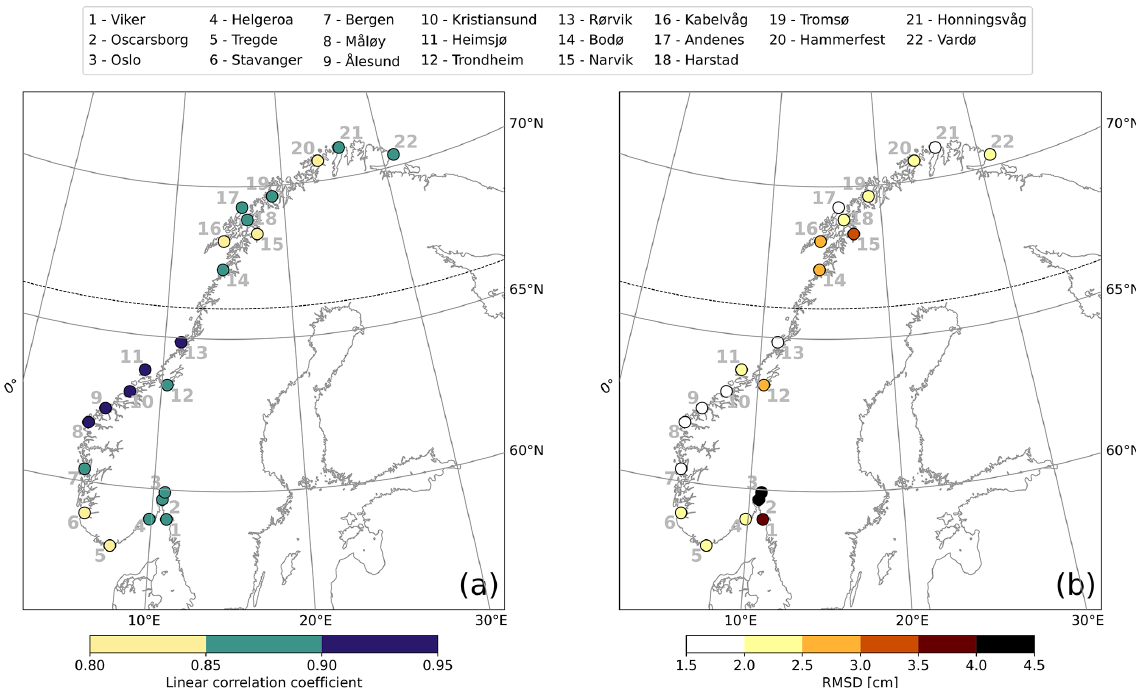
Figure 5. Comparison between coastal sea-level signals from in situ measurements and area-averaged remote sensing data. At each tide- gauge location, the linear correlation coefficient (a) and RMSD (b) between the detrended and deseasoned monthly mean SLA from the ALES altimetry dataset and from the tide gauge. The black dashed line indicates the 66 ◦ N parallel.